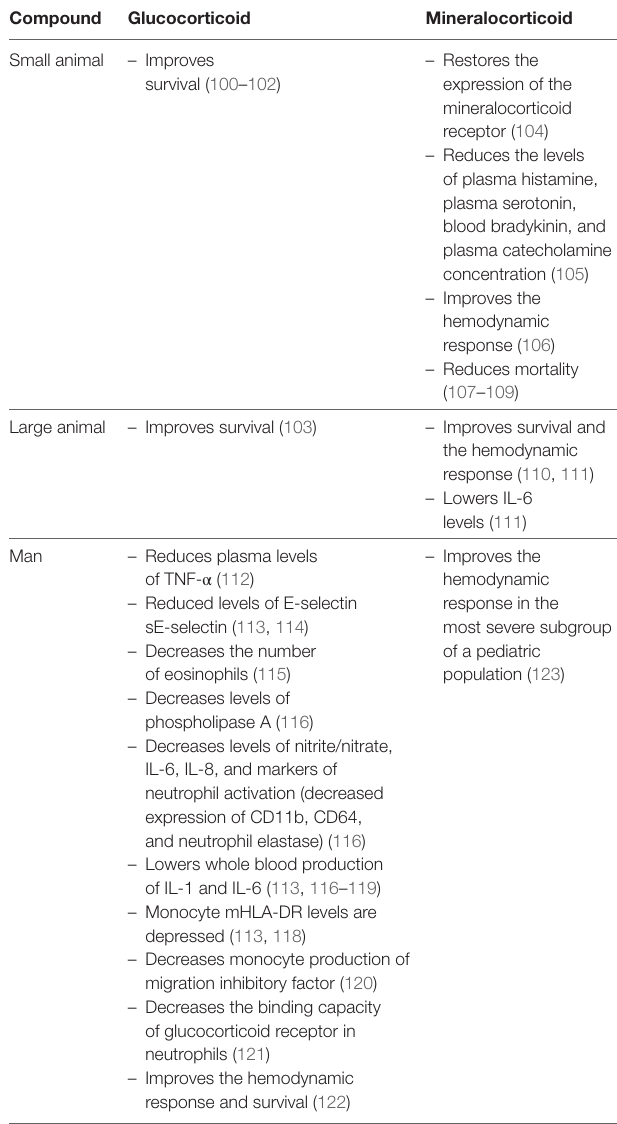
TaBle 2 | Main effects of glucocorticoid or mineralocorticoid administration during